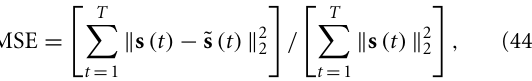
FIGURE 3 | Area under ROC curve (AUC) and d-Accuracy scores for data generated by VAR processes with orders from 1 to 7. The proposed method and the Wiener–Granger causality method are denoted by VBCCA( P ) and WGCA( P ), respectively, where P denotes the VAR model order used in the algorithm. All results are averages over 50 simulations with error bars indicating the 95% confidence intervals. The average scores are also shown as numerical values in the bar plot, where the values in parentheses are the size of one side of the confidence interval.